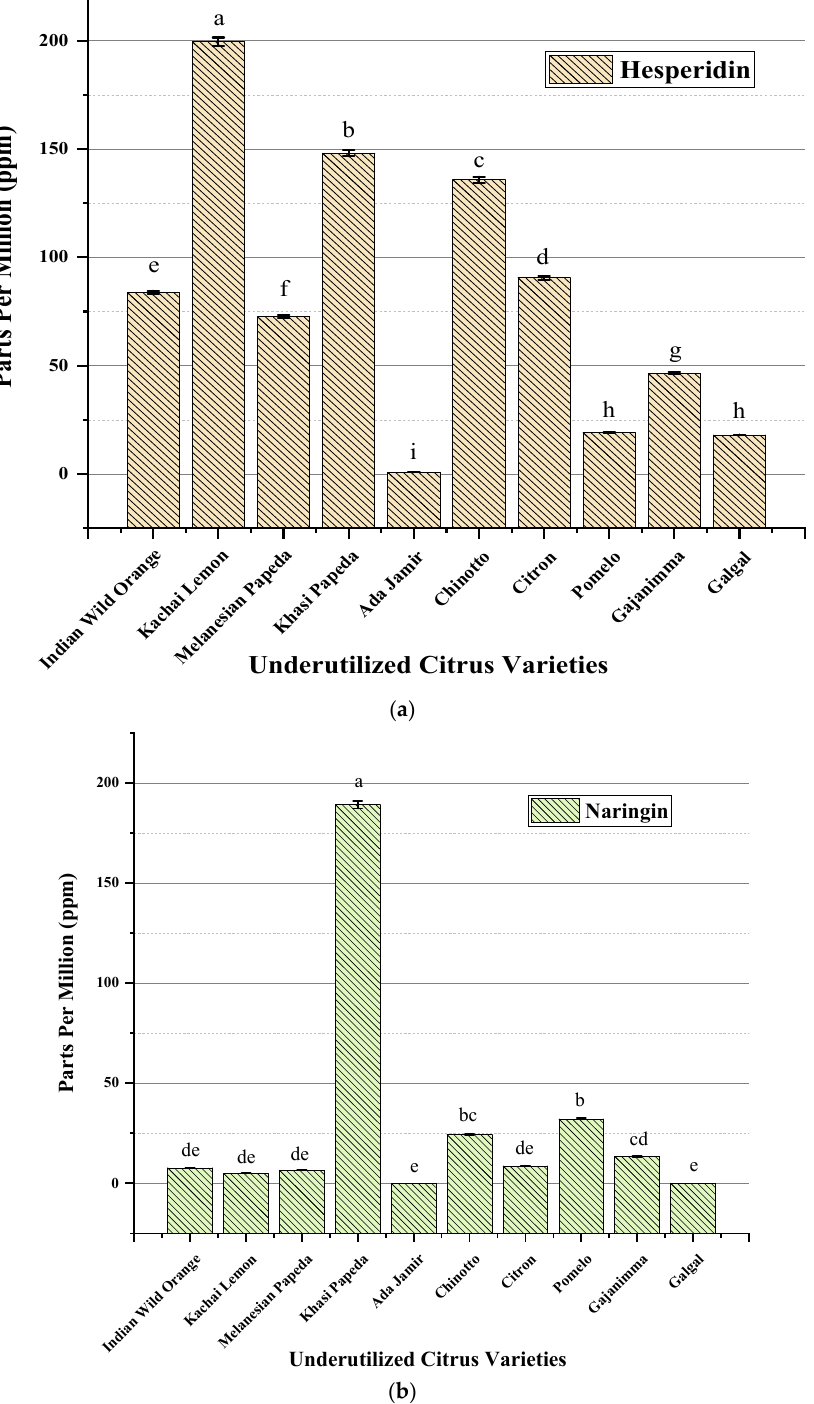
Figure 2. Flavonoid ( a ) hesperidin and ( b ) naringin content assessed in underutilized citrus varieties. Significant ANOVA p < 0.01. Letters a to i for hesperidin and a to e for naringin above mean (n = 3) bars denote significant differences at p < 0.01 according to Tukey’s HSD test.